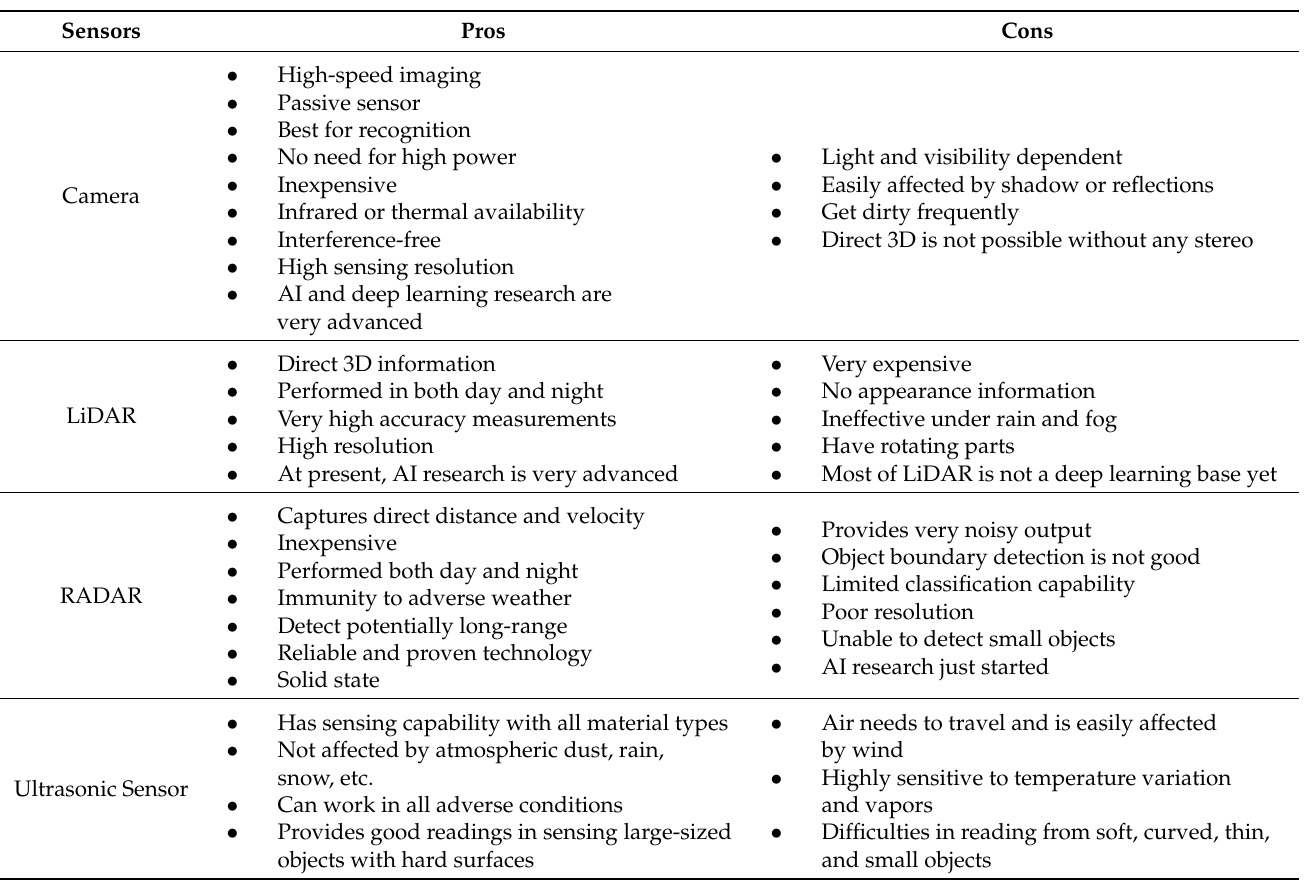
Table 3. Pros and cons of camera, LiDAR, RADAR, and ultrasonic detection technologies in AV systems.